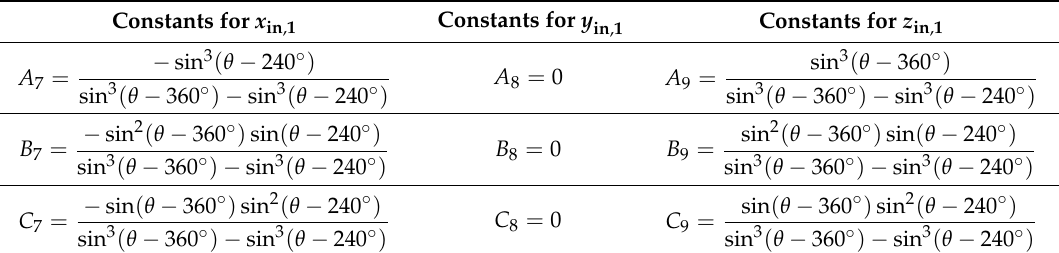
Table 3. Value of constants when 240 ◦ < θ < 360 ◦